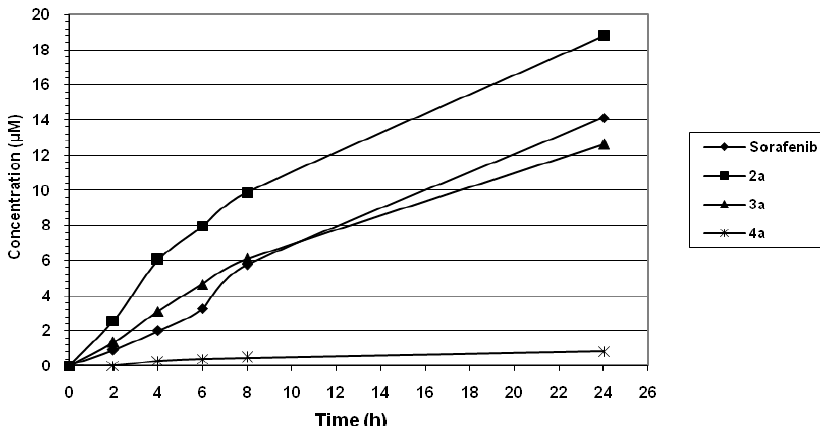
Figure 1. Release of the tested compounds at the basolateral side by CaCo-2 cell cultures. Hundred micromolar concentrations of the tested compounds were added at the apical